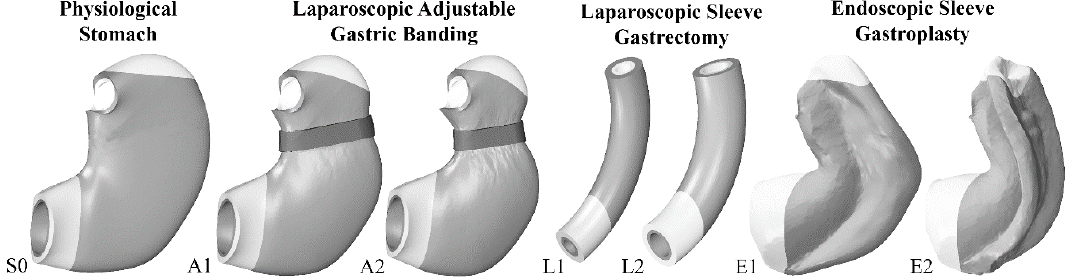
Figure 3. Computational mechanical models of the stomach before (S0) and after BS: laparoscopic adjustable gastric banding (A1: 25% band pretensioning; A2: 40% band pretensioning), laparoscopic sleeve gastrectomy (L1: 32 Fr bougie size; L2: 40 Fr bougie size), and endoscopic sleeve gastroplasty (E1: two-point stitch configuration; E2: three-point stitch configuration). Model development accounts for the principal regions of the stomach, such as fundus (white), corpus (grey), and antrum (white).